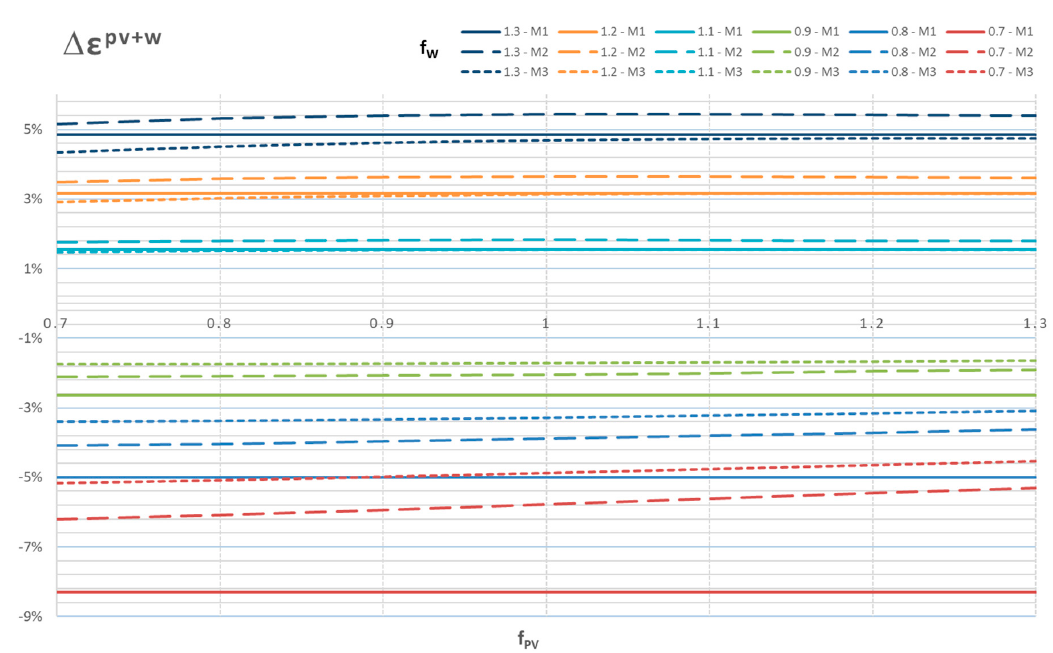
Figure 14. Variation of ε PV + W with the multiplication factors f pv and f w . (M1, M2 and M3 represent the results obtained by means of application of the normalisation methods 1, 2 and 3, respectively).